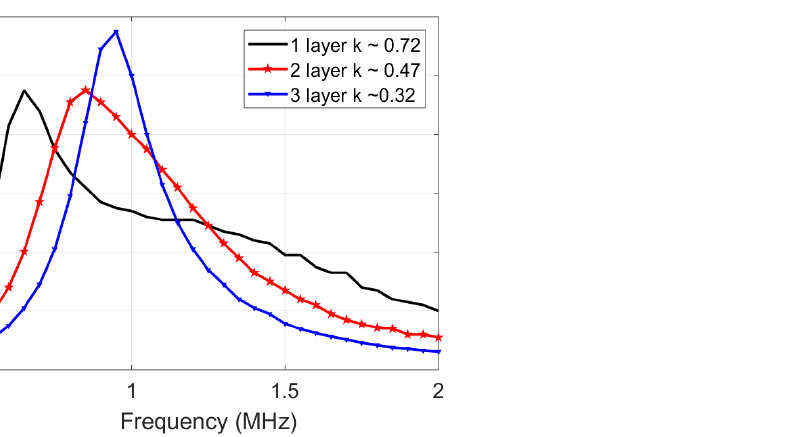
Figure 10. Channel response of the 10 µ H transmit and receive coils, tuned individually to 1 MHz using 2.2 nF capacitors.